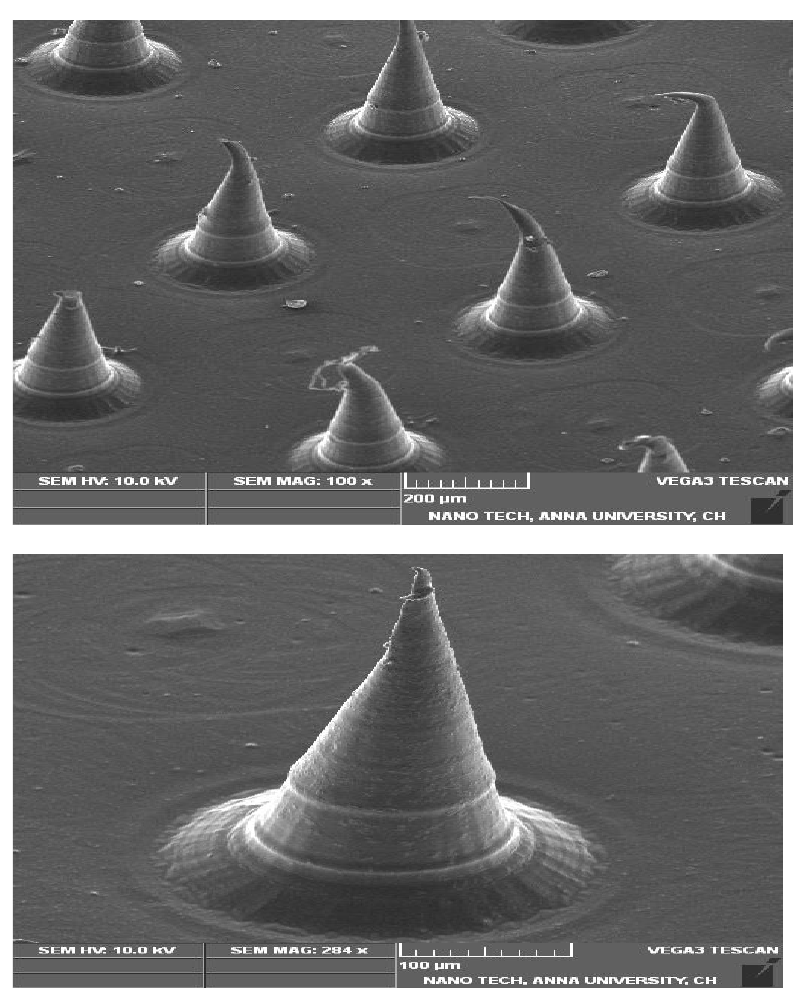
Figure 5. SEM images of the prepared β - ST - loaded CUBs - MN D . Table 3. Physical characteristics of the CUBs - MN D .